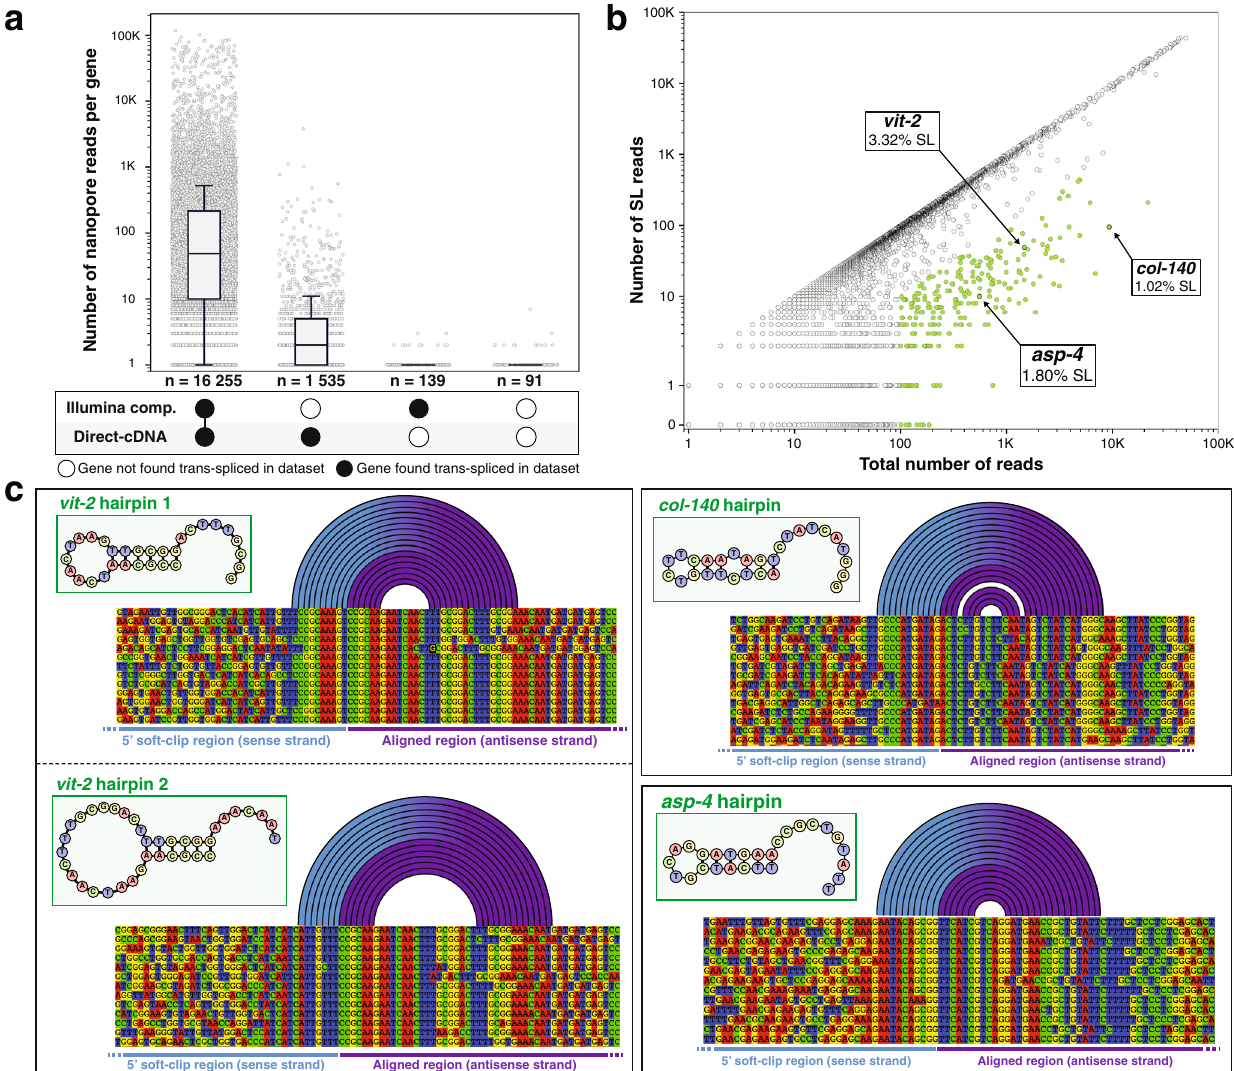
Fig. 4 | Natureofnon- trans -spliced mRNAs.a Gene expression and trans -splicing status.Wegroupedgeneinthe C.elegans genomeforwhichadirect-cDNAreadwas obtainedinthisstudyaccordingtothepresenceofevidenceof trans -splicinginthis study and/or in the compendium of RNA-seq we previously analyzed 14 . For each gene, we plotted the number of Nanopore reads we obtained as a proxy for gene expression level. The boxes show the quartiles of the dataset while the whiskers extendtoshowtherestofthedistribution,exceptforpointsthataredeterminedto be “ outliers ” using a method that is a function of the interquartile range (python